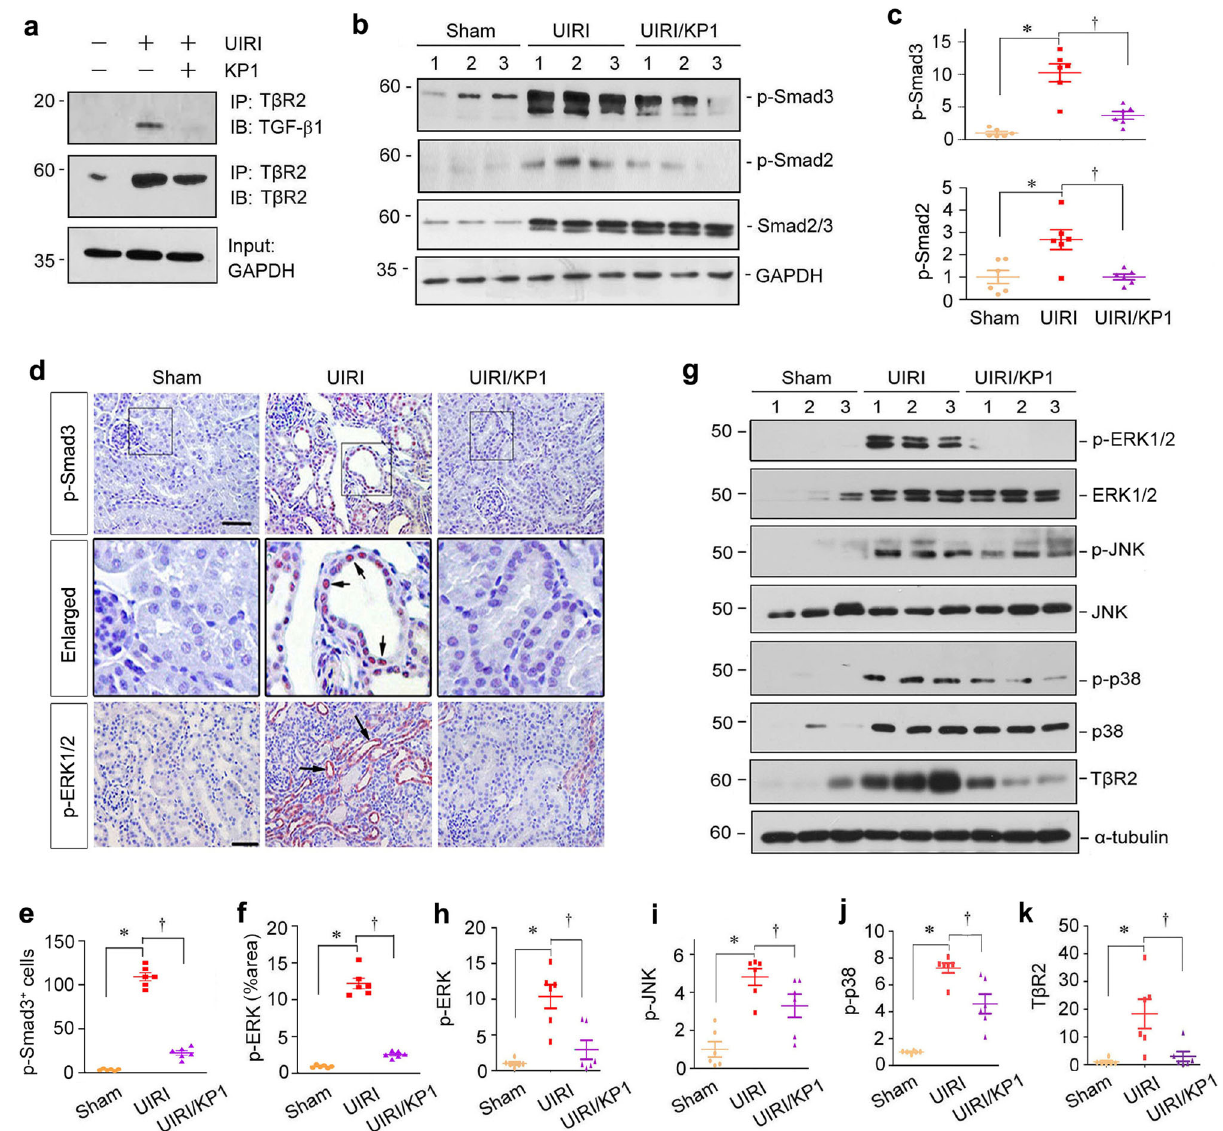
Fig. 5 KP1 inhibits TGF- β signaling in UIRI mice. a Co-immunoprecipitation showed that KP1 blocked the interaction between TGF- β 1 and T β R2 in vivo. b , c KP1 inhibited Smad2/3 activation in vivo. Representative Western blot analyses ( b ) and quantitative data ( c ) of p-Smad3 and p-Smad2 are shown. P values: <0.001, <0.001 (p-Smad3); 0.002, 0.002 (p-Smad2). n = 6 biologically independent animals. d Representative micrographs of immunohistochemical staining of p-Smad3 and p-ERK1/2. Boxed areas are enlarged. Arrows indicate positive staining. Scale bar, 50 µ m. e , f Quantitative data of p-Smad3 positive cells number ( e ) and p-ERK positive staining area ( f ) in each high-power fi eld. P values: < 0.001, < 0.001 (p-Smad3); < 0.001, < 0.001 (p-ERK); n = 6 biologically independent animals. g KP1 blocked the activation of MAPK and T β R2 expression in vivo. h – k Quantitative data